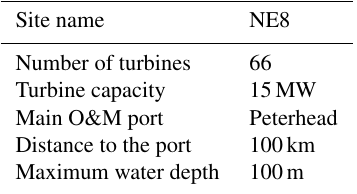
Table 1. Characteristics of the case study floating wind